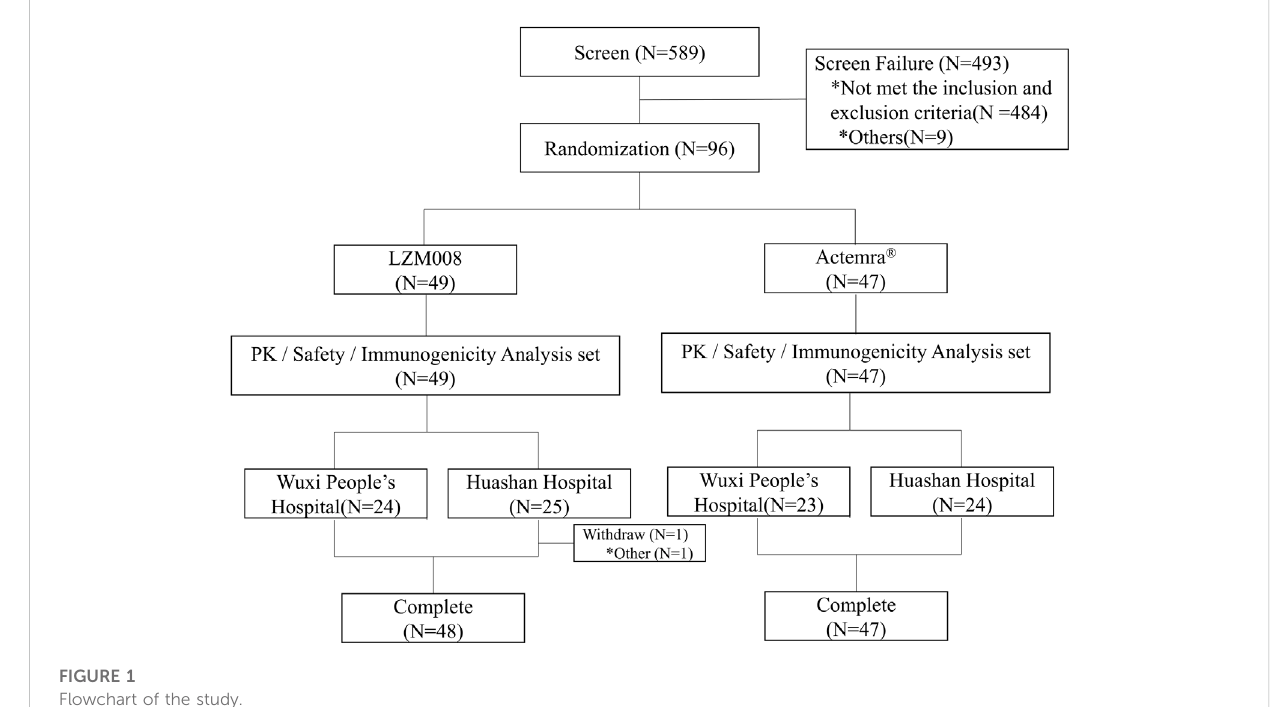
FIGURE 1 Flowchart of the study.